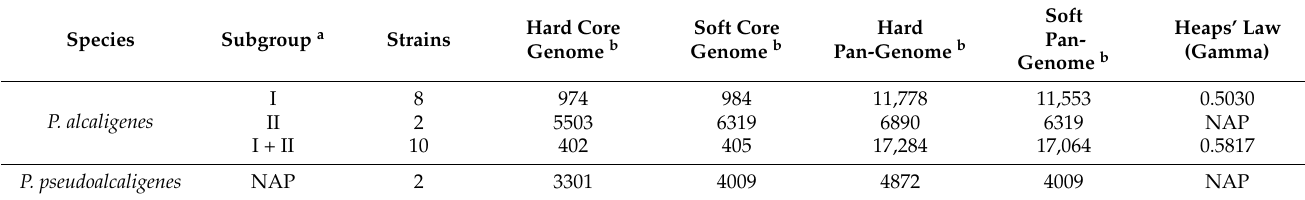
Table 3. Comparison of core and pan-genomes of Pseudomonas alcaligenes and Pseudomonas pseudoalcaligenes